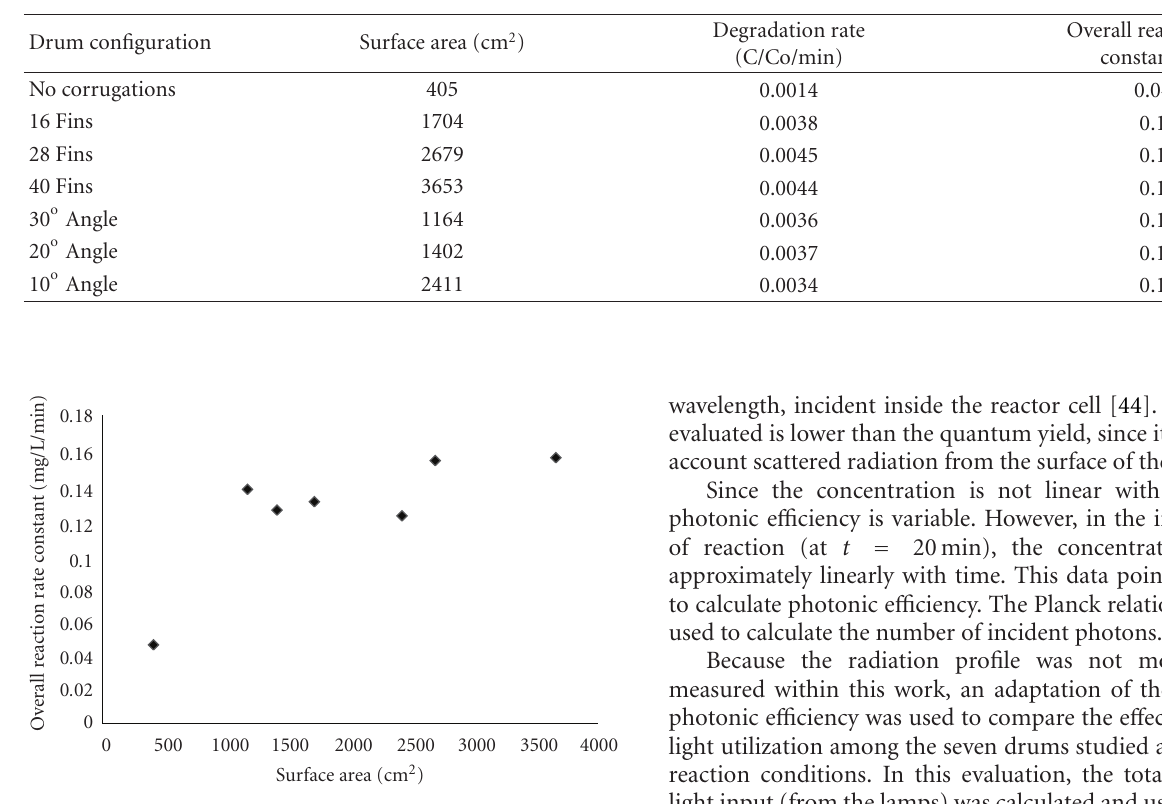
Table 2: Initial degradation rate and Langmuir-Hinshelwood kinetic constants.